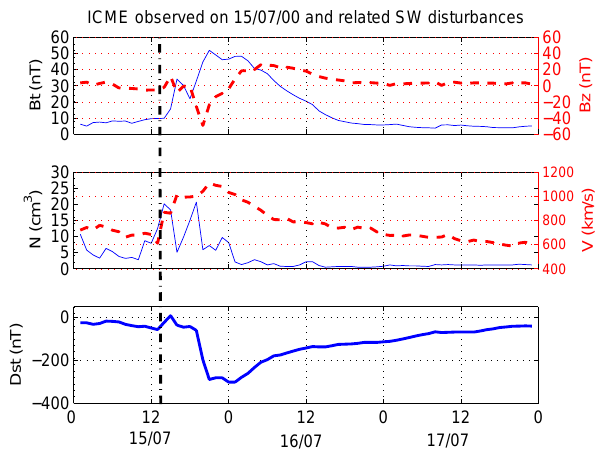
Fig. 1. Plot showing the variation of the IMF total field B t , the SW density N (solid lines), the B z component of the IMF and the SW velocity V (dashed lines), following the passage of an ICME, ob- served by the WIND spacecraft on 15/16 July 2000. The vertical solid dashed line labels the shock ahead of the ICME. This ICME event has also been reported in Messerotti et al.